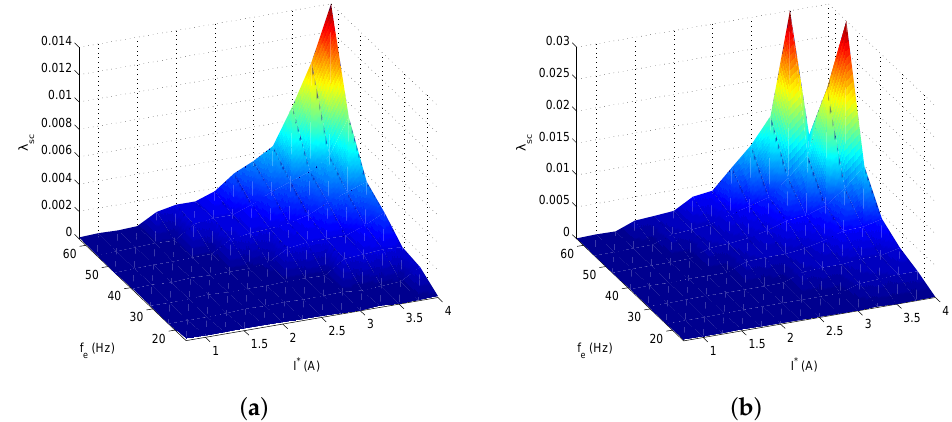
Figure 5. Optimal values of λ sc to attain f sw ≤ 11 kHz ( a ) and to attain f sw ≤ 8 kHz ( b ).